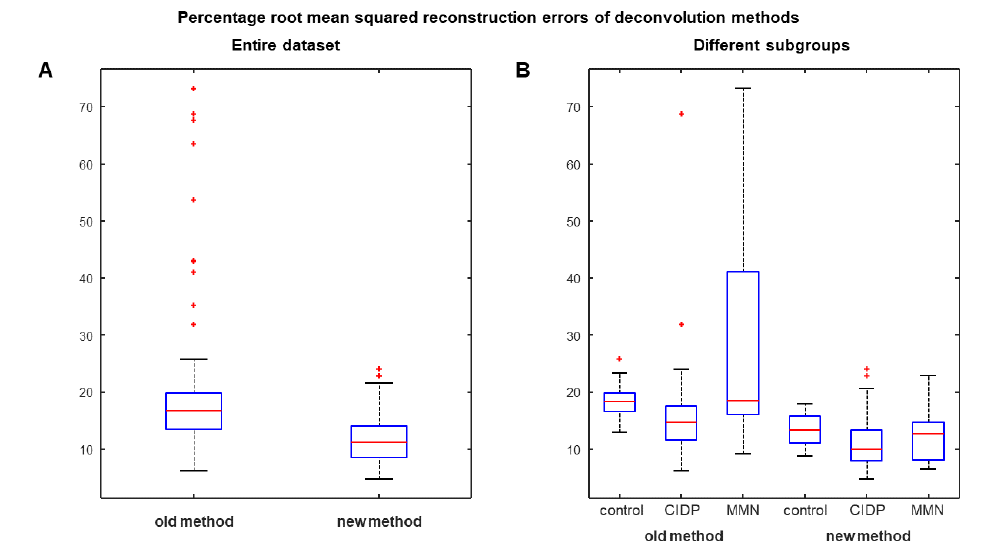
Figure 4. Comparison of the percentage reconstruction errors of the deconvolution methods either excluding or including the SAW in estimating the kernel (old and new method, respectively). Box and whiskers plots are displayed, showing median, quartiles and range (outliers indicated individually by red + ) for ( A ) the entire dataset and ( B ) the groups of patients. All paired comparisons (either of the entire dataset or of each group of patients) are highly statistically significant under the Wilcoxon signed-rank